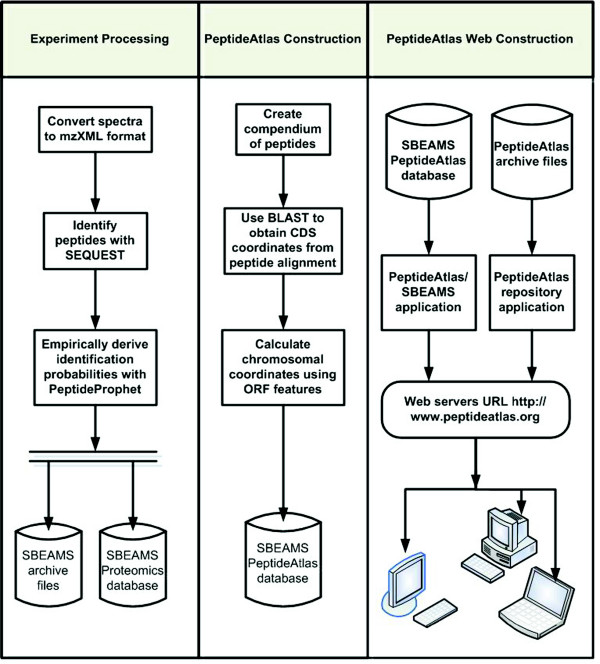
PeptideAtlas processing, creation, and interfaces. The first column outlines experiment level processing with SEQUEST [21] and PeptideProphet [22], the second column shows major stages in the construction of a PeptideAtlas [18] using BLAST [24] to obtain coding sequence (CDS) coordinates, and the third column shows the data, business logic, and presentation tiers for a PeptideAtlas.